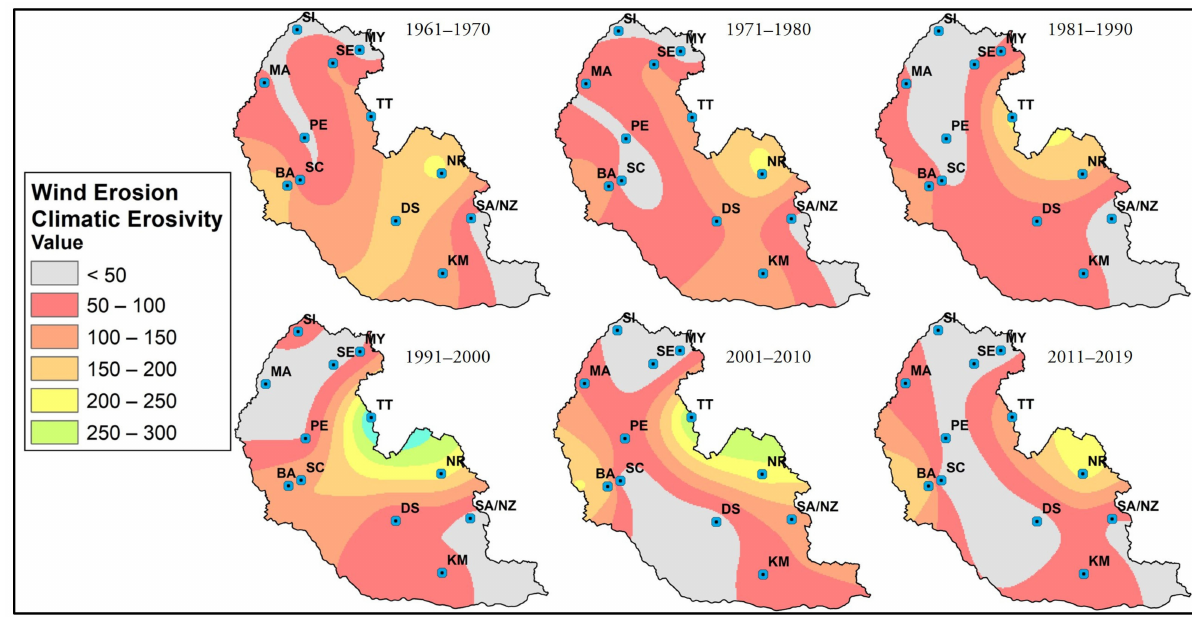
Figure 14. Spatiotemporal variation of CE by